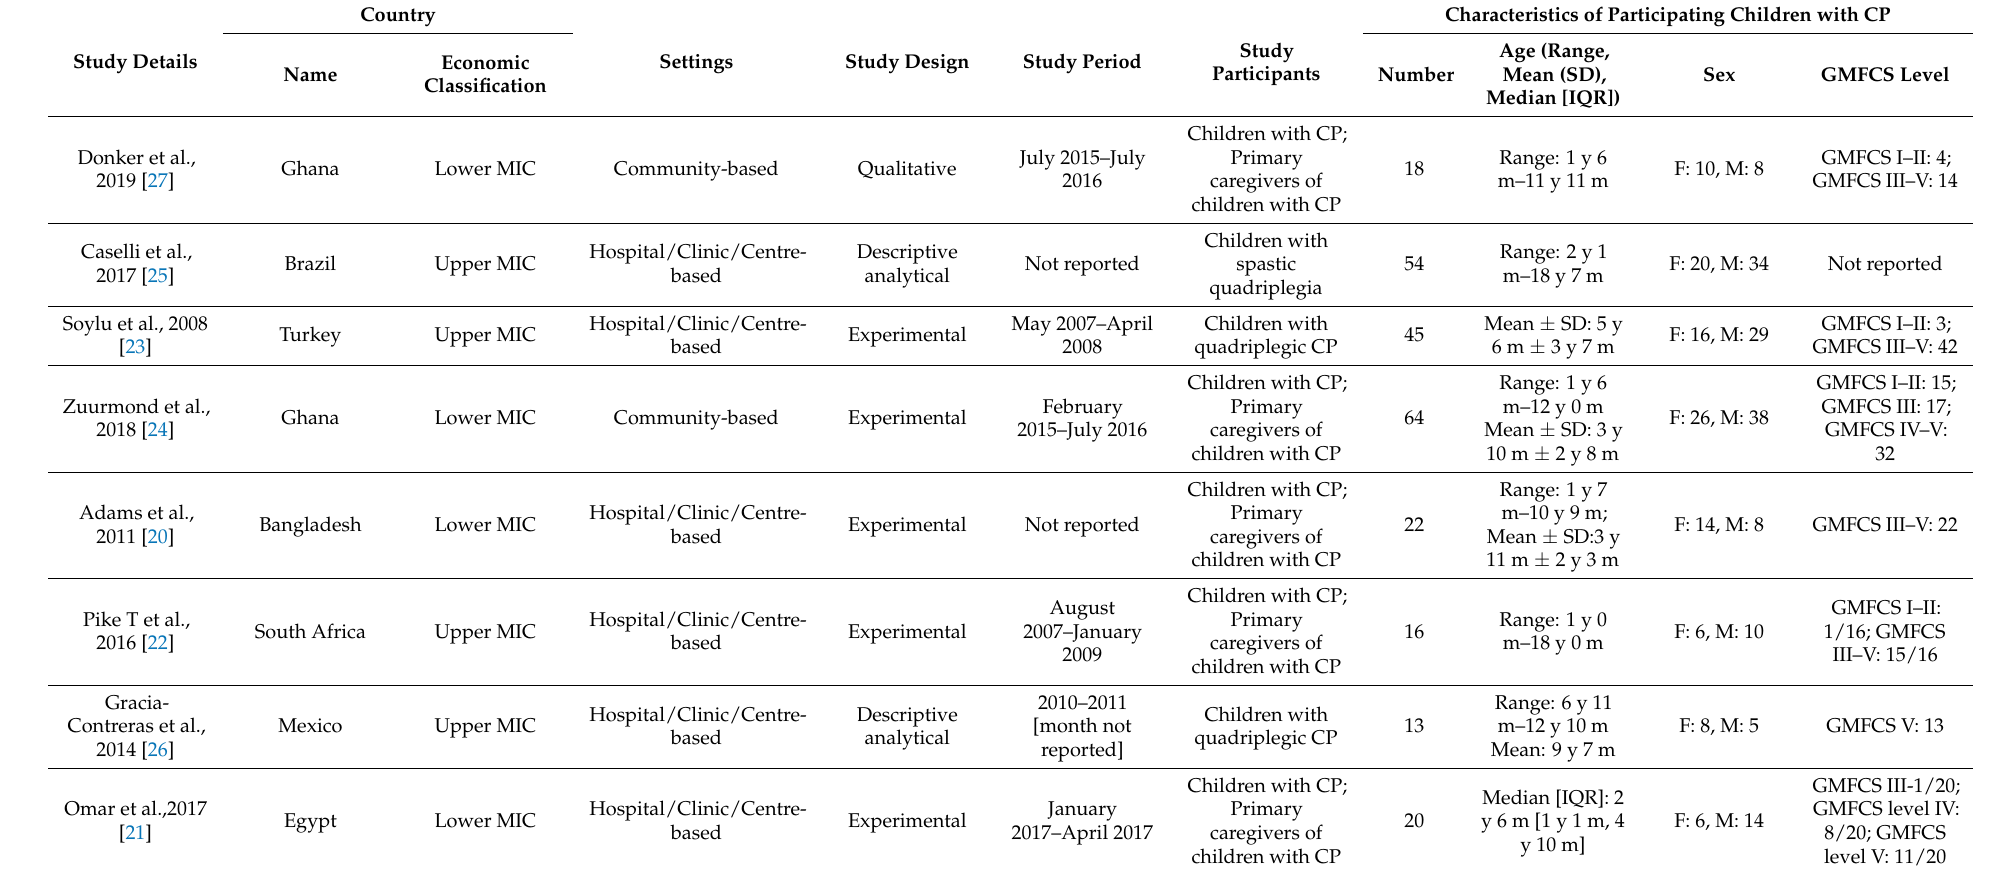
Table 1. Characteristics of the included